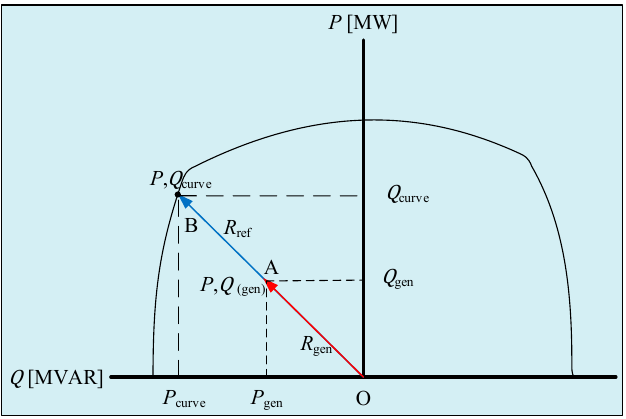
Figure 11. Relationship between 𝑃 , 𝑄 , 𝜃 , 𝑅 gen , and 𝑅 ref . The algorithm for testing the generator capability curve is shown in Figure 12.